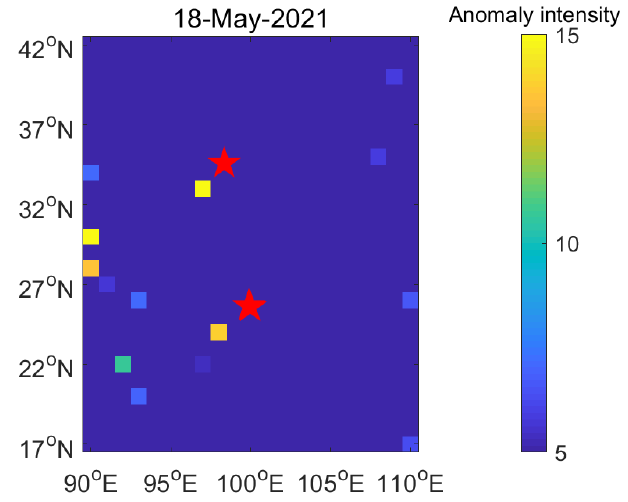
Figure 16. The relative power spectrum on 18 May 2021.